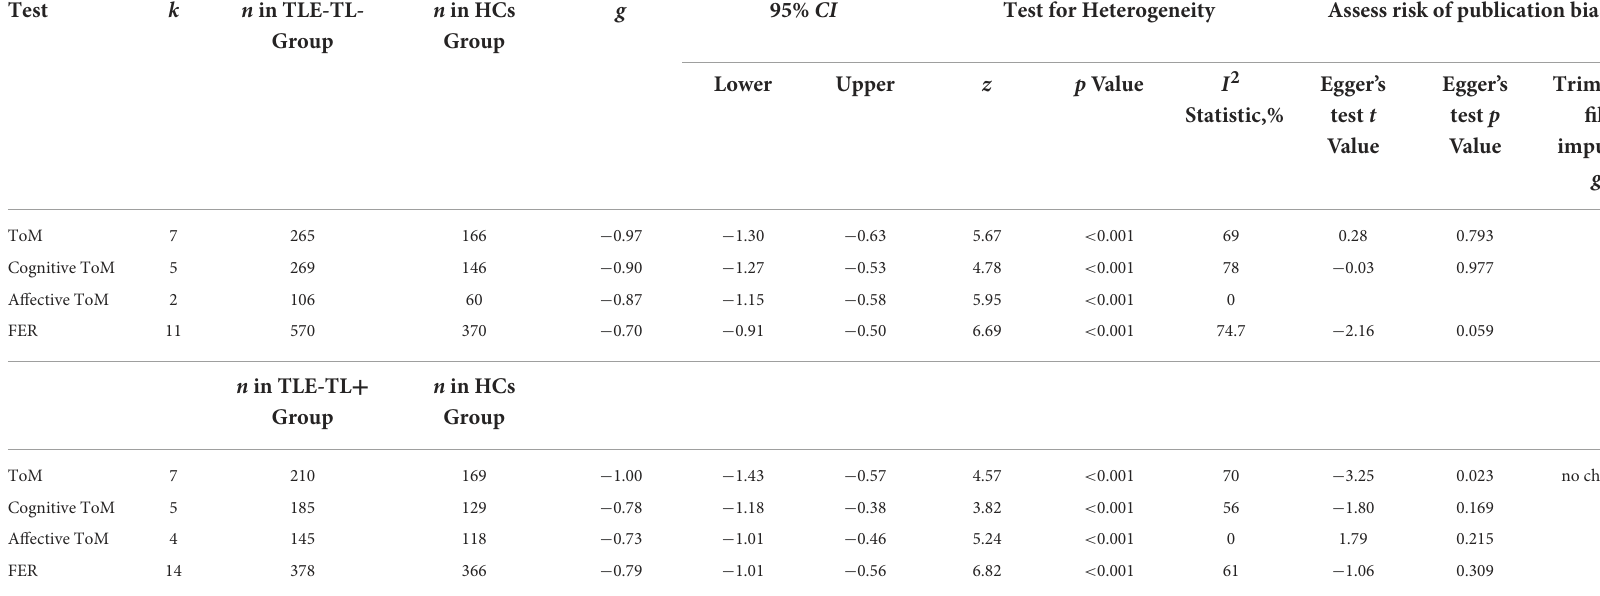
TABLE 4 Mean effects for ToM and FER subcomponents comparing adults with TLE-TL- and TLE-TL + against healthy controls and tests for publication bias. n in HCs g 95% CI Test for Heterogeneity Assess risk of publication bias Test k n in TLE-TL- Group Group